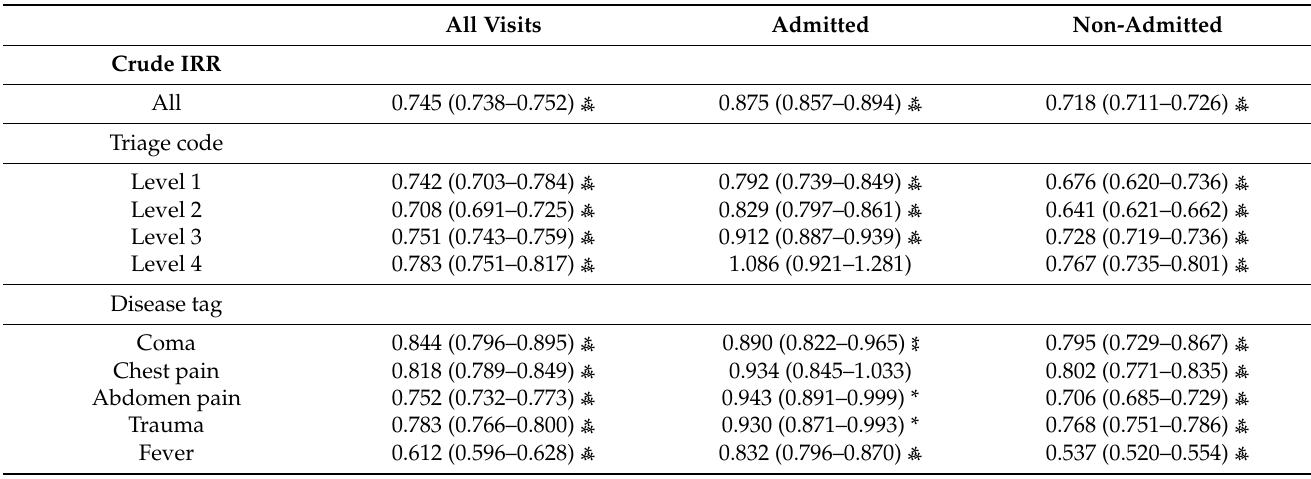
Table 1. Comparisons of ED visits before and after the start of COVID-19 pandemic. All